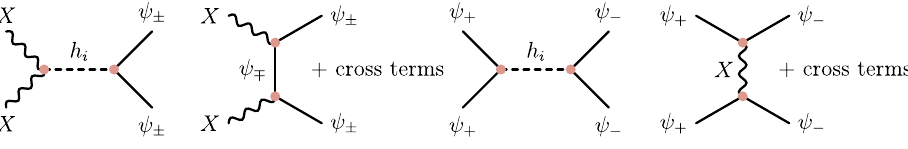
Fig. 5 Dark matter conversion processes involving X and ψ ± . These processes are important to keep thermal equilibrium within the dark sector